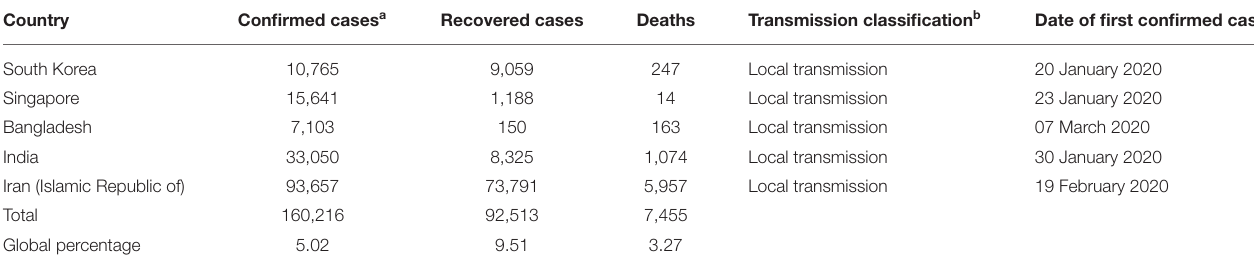
TABLE 1 | Number of people affected by coronavirus disease 2019 (COVID-19) in selected five Asian countries (to April 30, 2020). Country